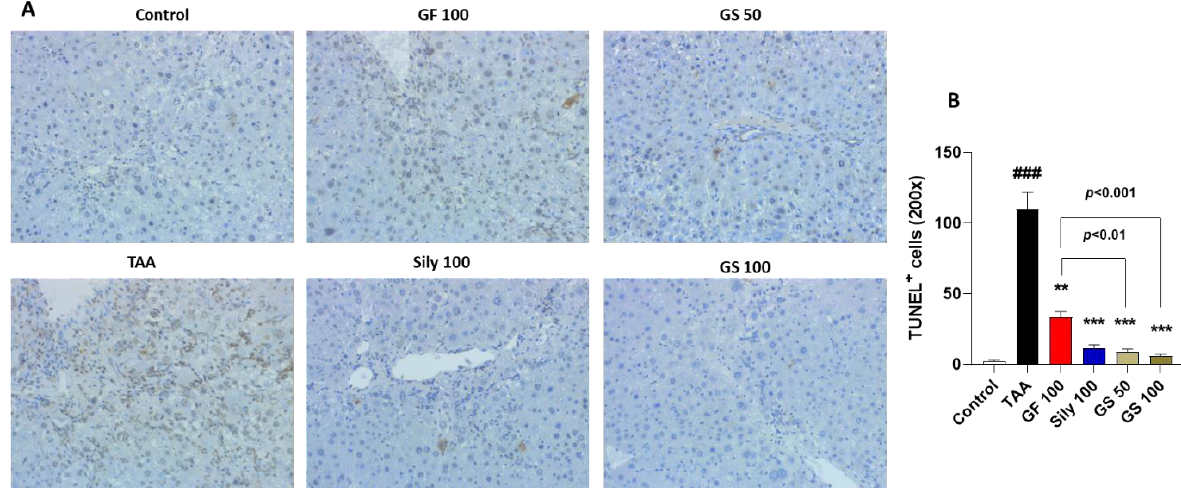
Figure 2. Synergistic effects of GS on the liver cell deaths by attenuations of oxidative stress. ( A ) TUNEL assay. ( B ) Quantification of TUNEL positive cells. Data were expressed by mean ± S.E.M. ### p < 0.001 for Control vs. TAA. ** p < 0.01, and *** p < 0.001 for TAA vs. drug treatments ( n = 4 for IHC analysis). Images were captured by light microscopy condition (200× magnifications).